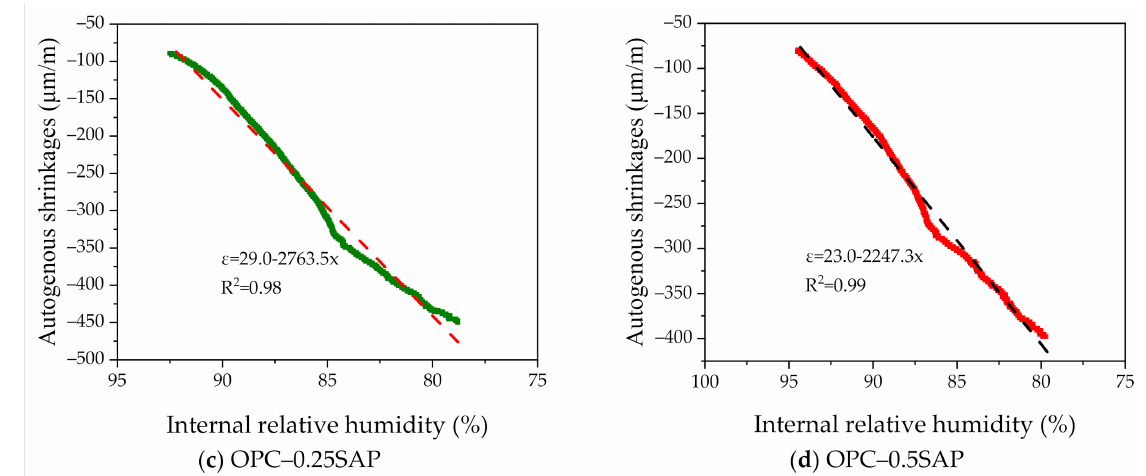
Figure 8. Correlation between AS and the internal relative humidity of specimen.